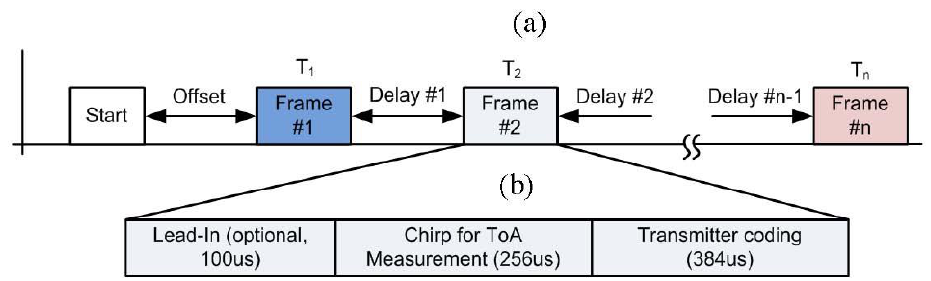
Figure 2. Locating operation: Transmitting sequence ( a ), Transmitted frames ( b